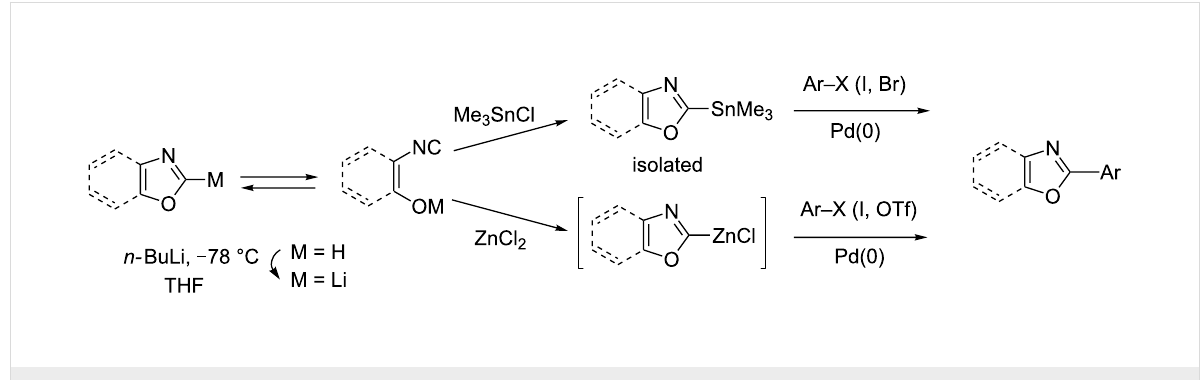
Scheme 2: Stille and Negishi cross-coupling methodologies in oxazole series [28,30,31,33,34].